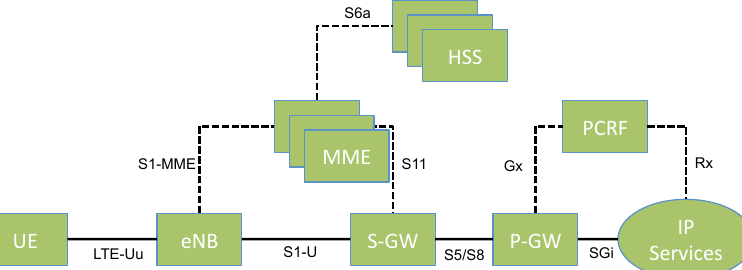
Figure 2. VM-based LTE cellular network architecture with multiple virtualized MMEs and